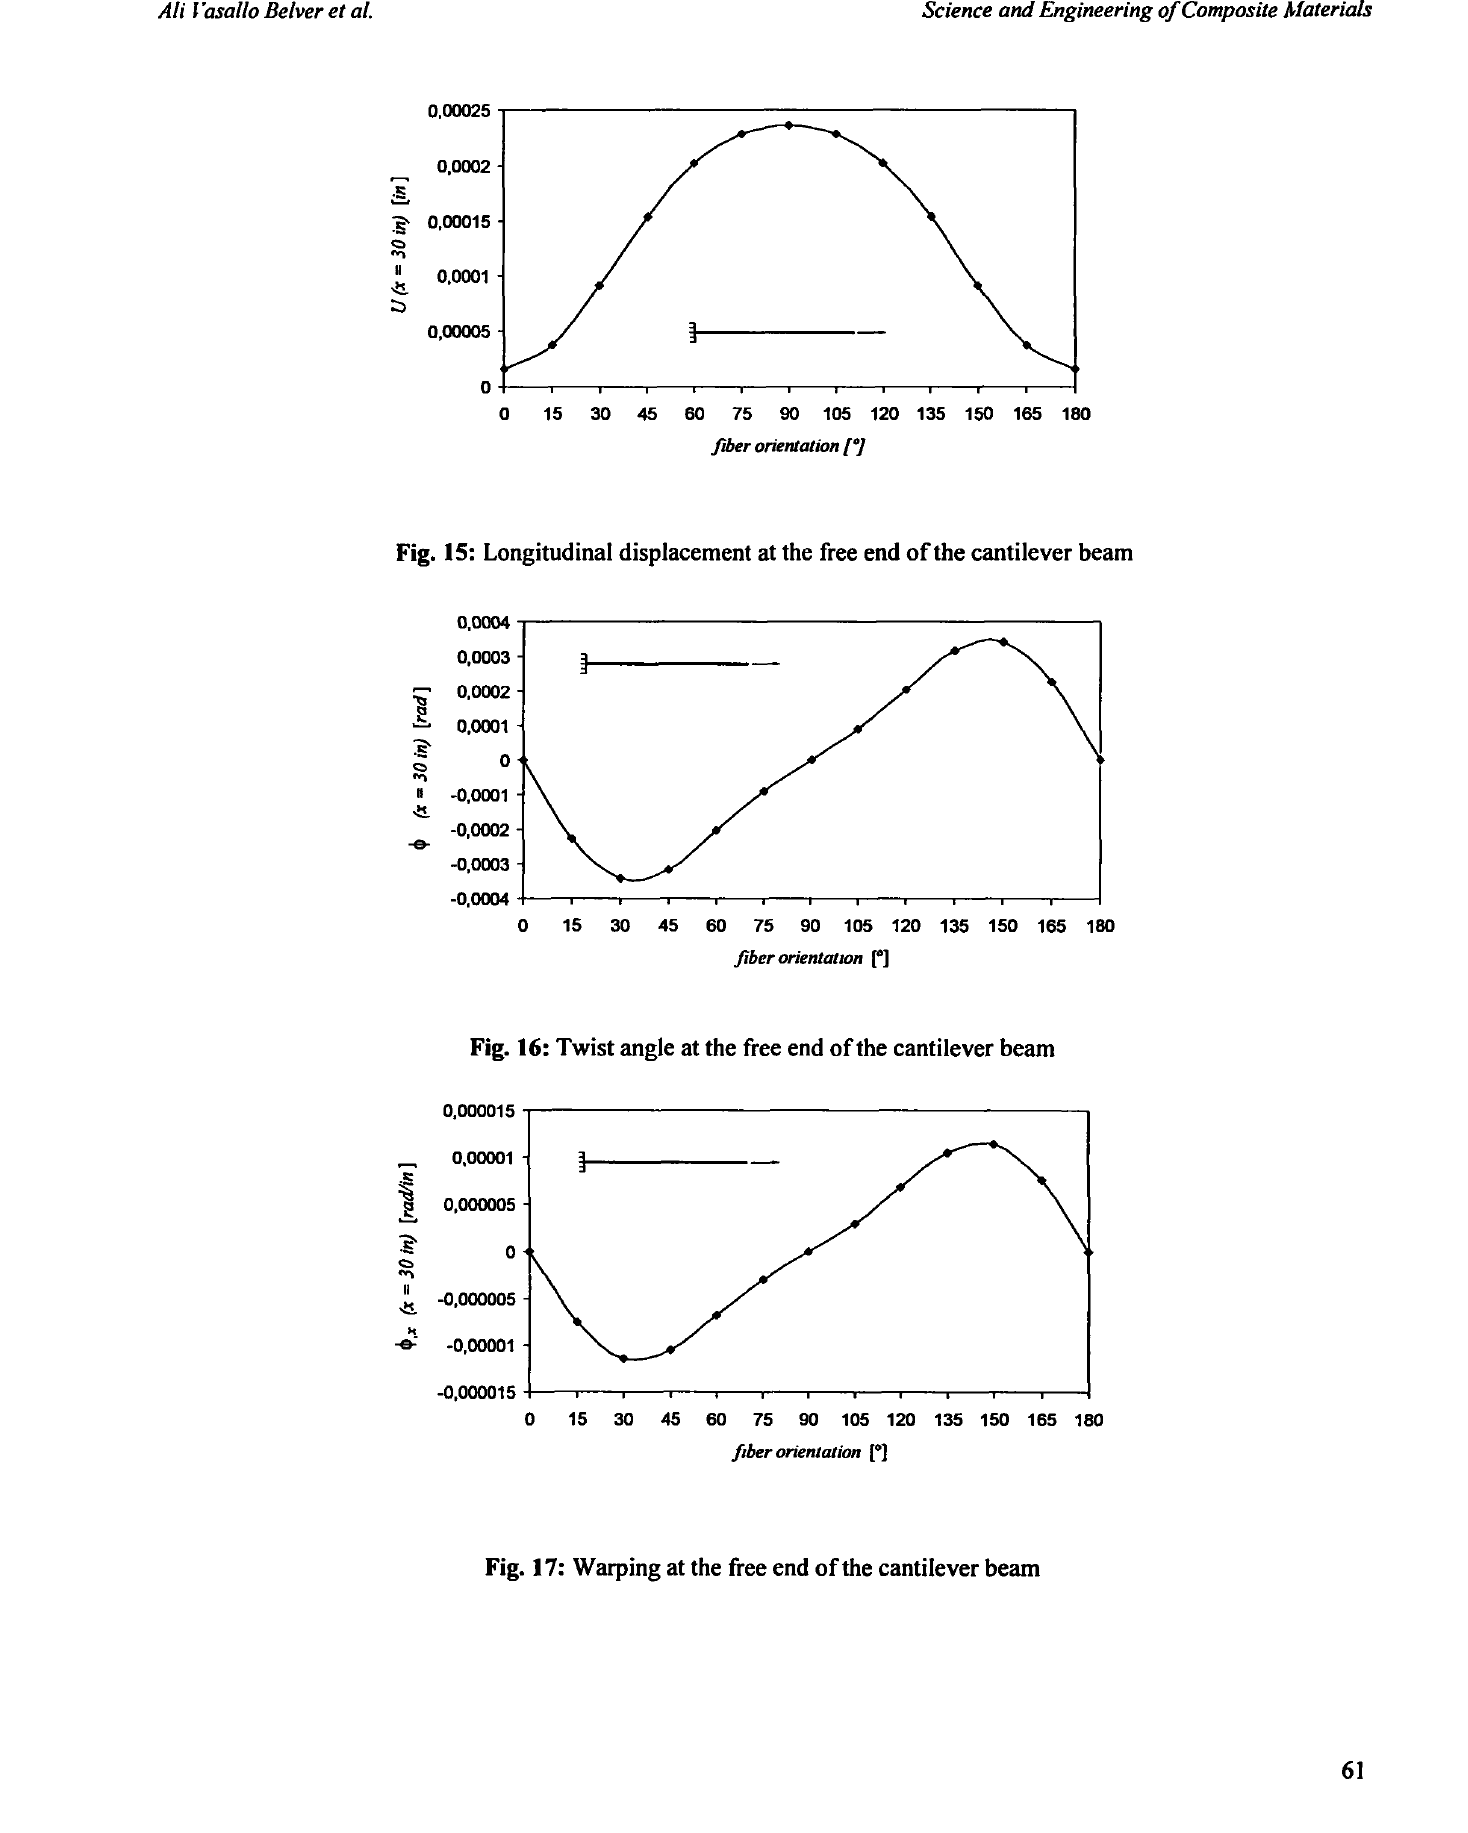
Fig. 17: Warping at the free end of the cantilever